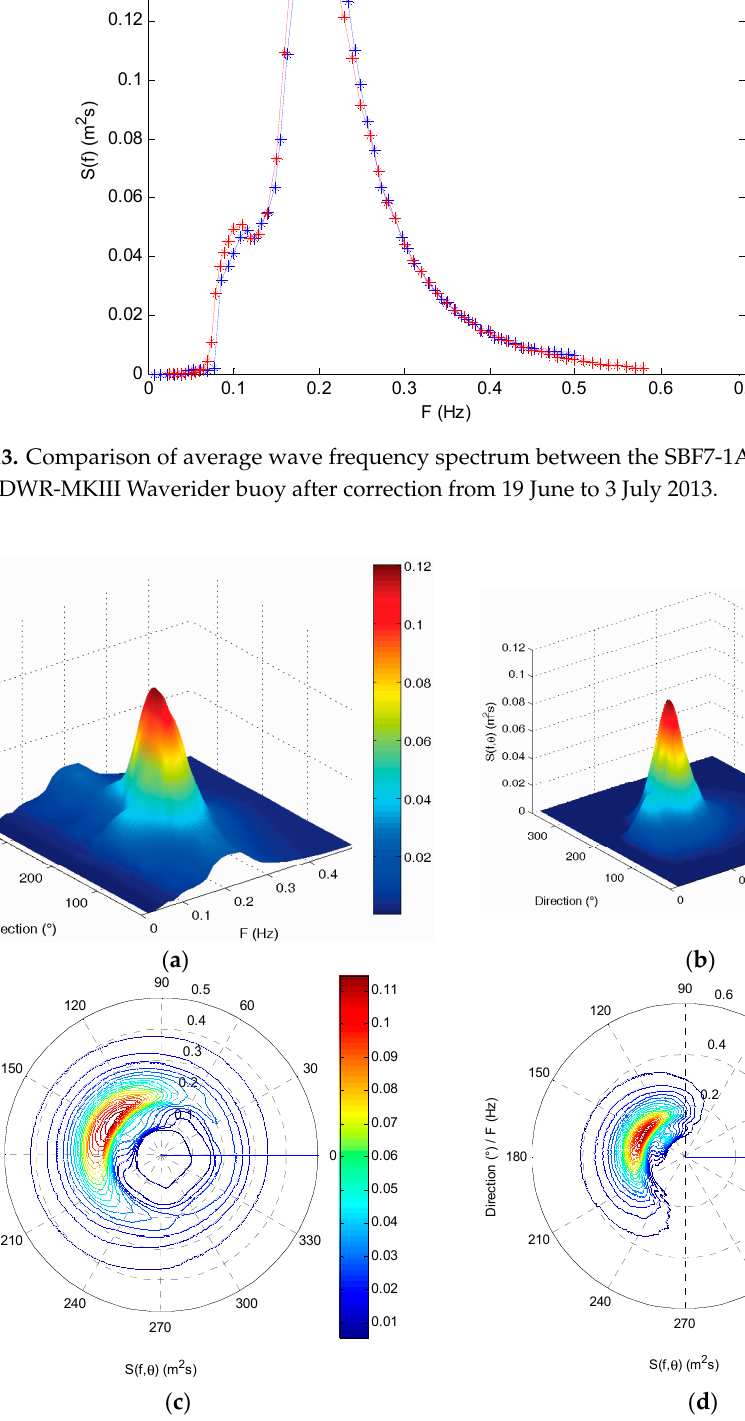
Figure 14. Comparison of average directional wave spectrum between the SBF7-1A GPS wave buoy and the DWR-MKIII Waverider buoy after correction from 19 June to 3 July 2013: ( a , c ) average directional wave spectrum of the SBF7-1A GPS wave buoy; ( b , d ) average directional wave spectrum of the DWR-MKIII Waverider